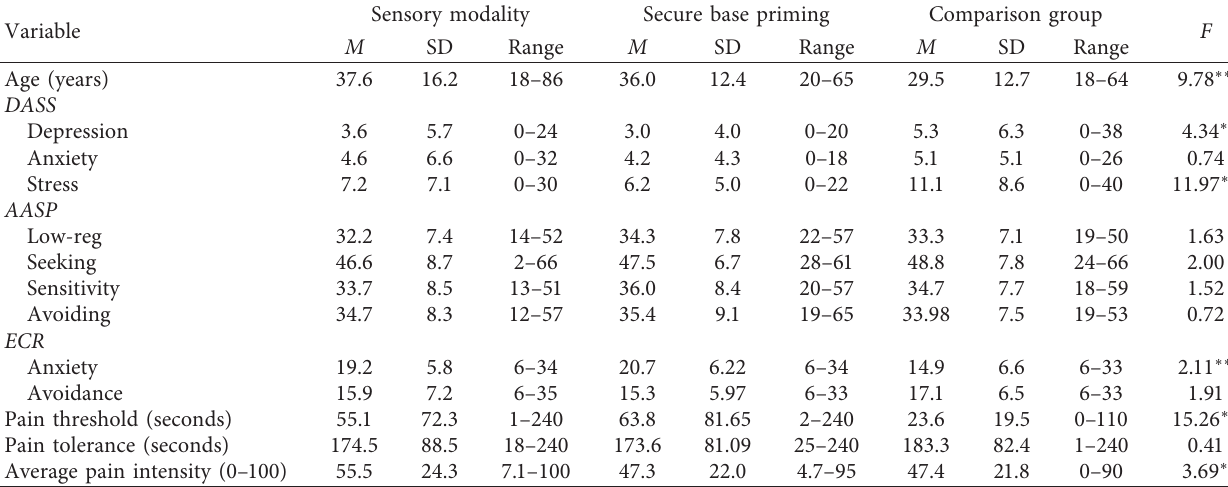
Table 2: Details of participant study variables presented according to coping strategy, compared using ANOVA, N � 272. Sensory modality Variable